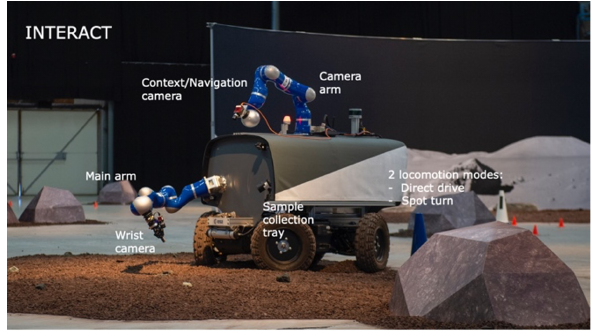
Figure 3. The INTERACT